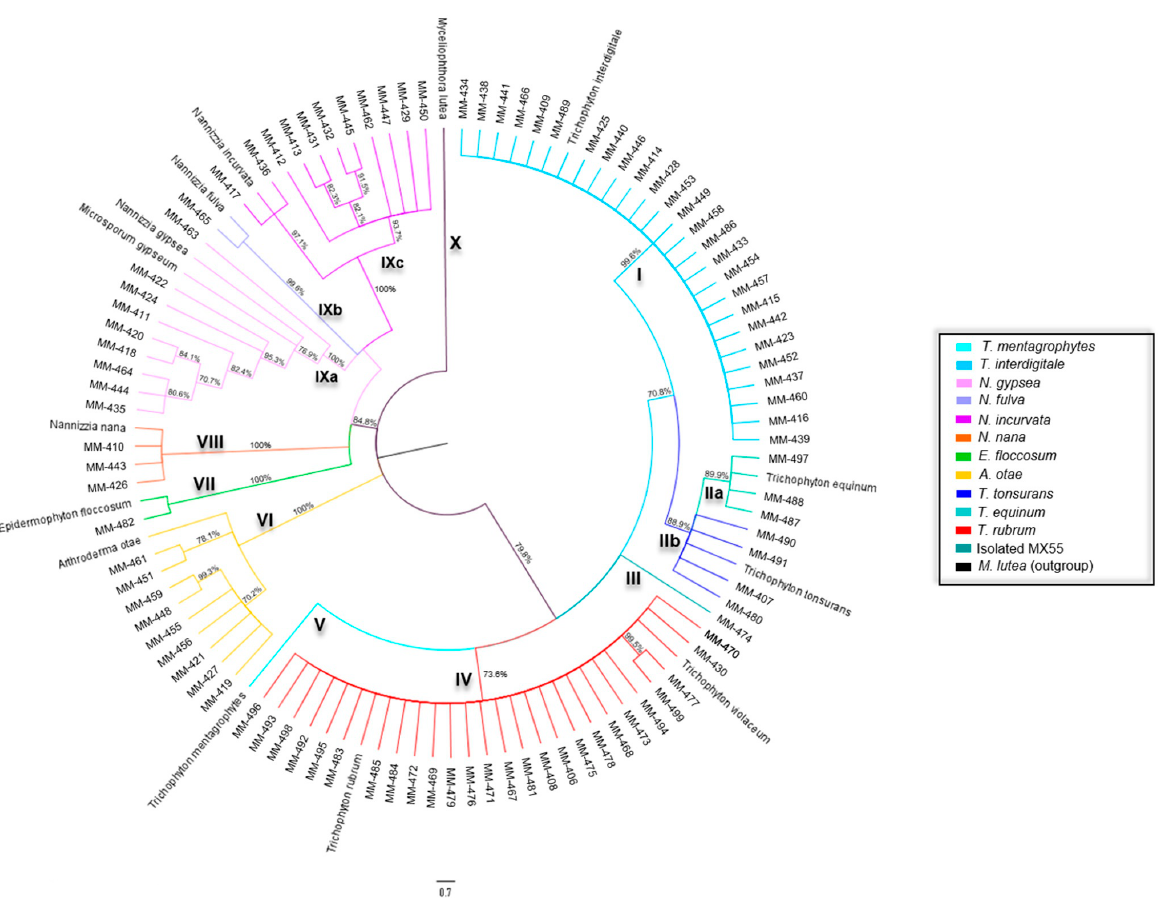
Figure 1. The phylogenetic tree was constructed using concatenated DNA sequences of markers ITS, BT2 , and Tef-1 α of dermatophyte species based on maximum likelihood method using MEGA X. Bootstrap support values are displayed at nodes. Table 4. Genotypic identification of dermatophyte isolates included in the study by Bayesian inference. Isolates and Reference Sequences Obtained from